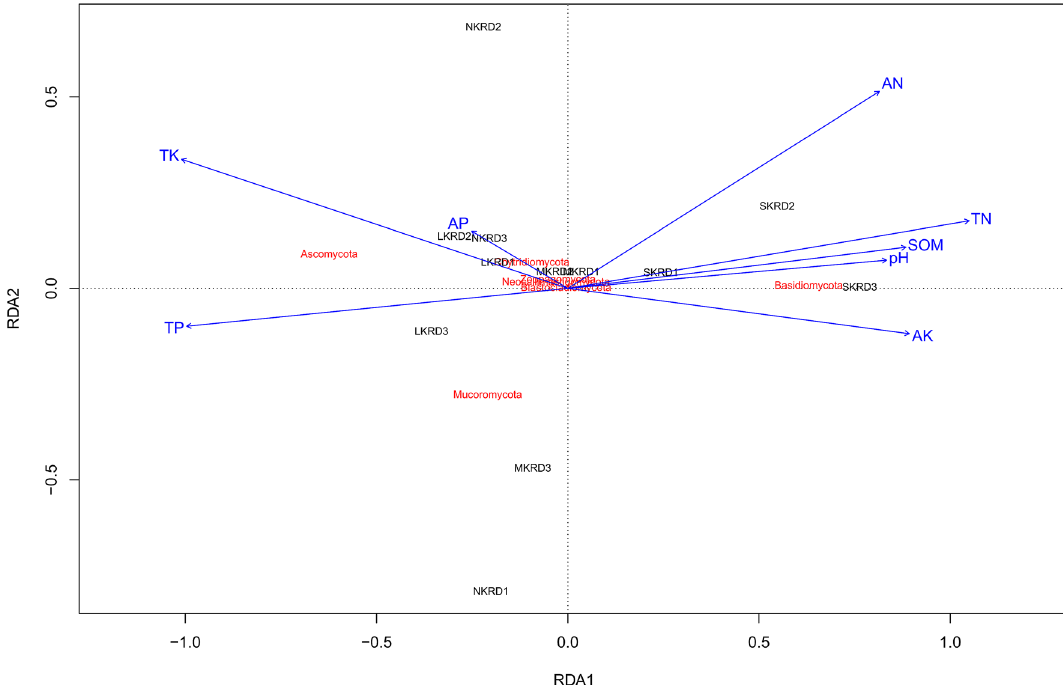
Figure 3. The distance-based redundancy analysis (db-RDA) diagram was used to show distribution of soil fungal communities in karst rocky desertification areas. Study sites are labeled in black No KRD (NKRD), latent KRD (LKRD), moderate KRD (MKRD), and severe KRD (SKRD). Soil properties are labeled in blue. Soil organic matter (SOM), total and available nitrogen (TN and AN), total and available phosphorus (TP and AP), and total and available potassium (TK and AK). Phylum is labeled in red.